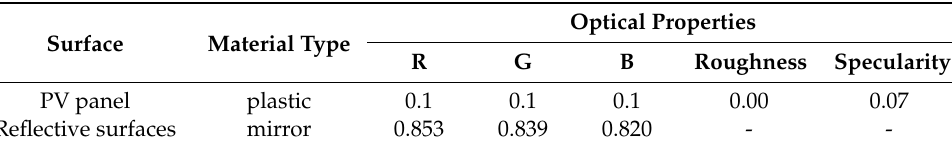
Table 4. Optical properties of materials used in solar radiation